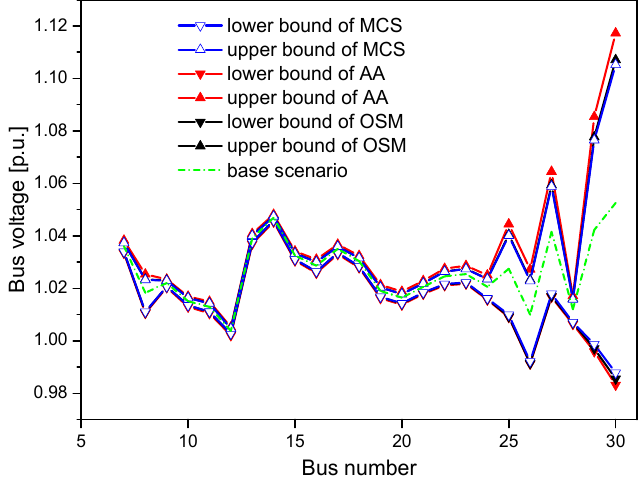
Figure 8. Ranges of load voltages acquired by three different methods.